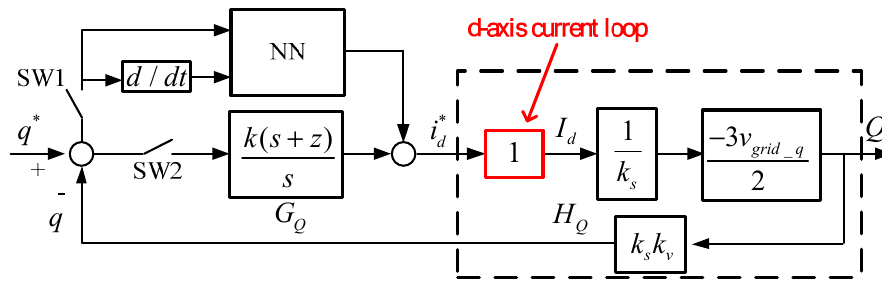
Figure 10. Control loop of reactive power controller.